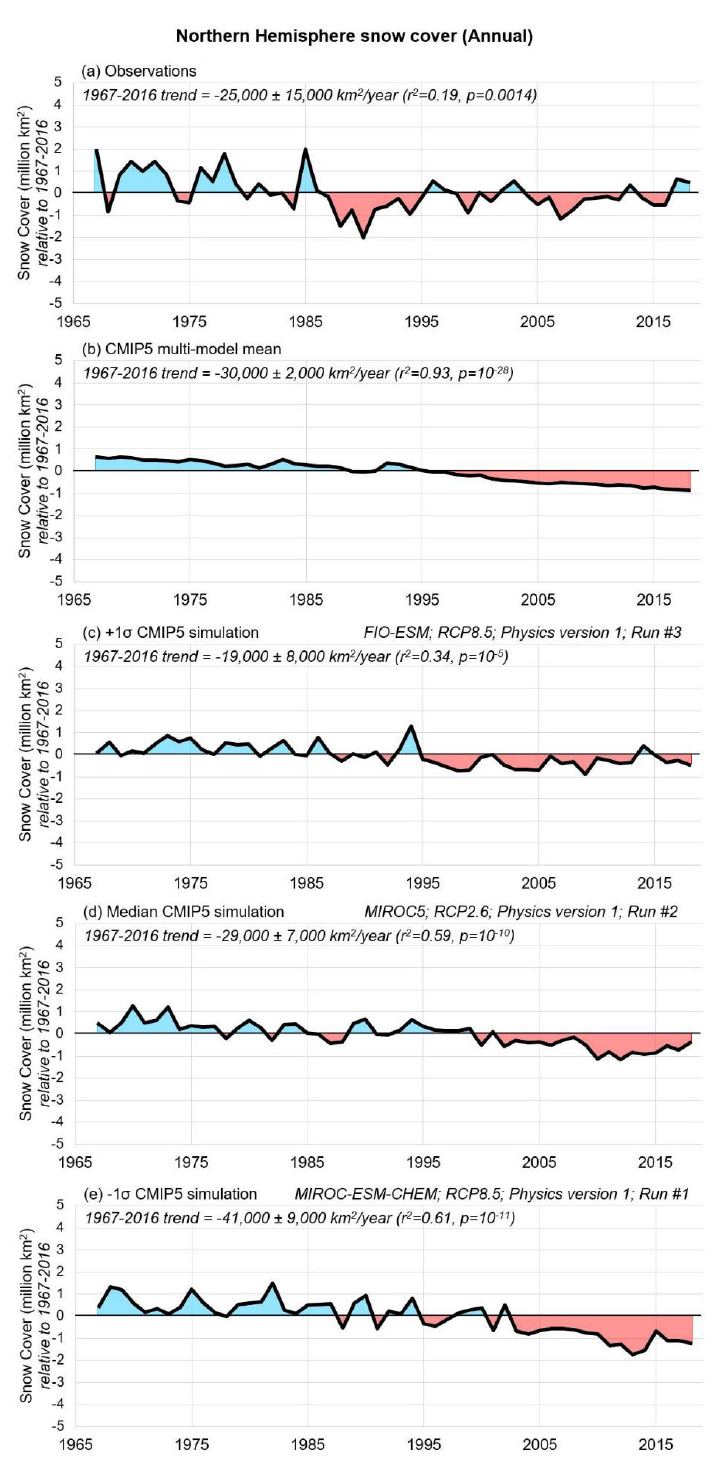
Figure 4. Annually-averaged trends in Northern Hemisphere snow cover (relative to 1967–2016) according to ( a ) observations; ( b ) the CMIP5 multi-model mean; ( c ) the CMIP5 simulation equivalent to +1 SD; ( d ) the median CMIP5 simulation; and ( e ) the CMIP5 simulation equivalent to −1 SD. The uncertainty ranges associated with the linear trends correspond to twice the standard error associated with the linear